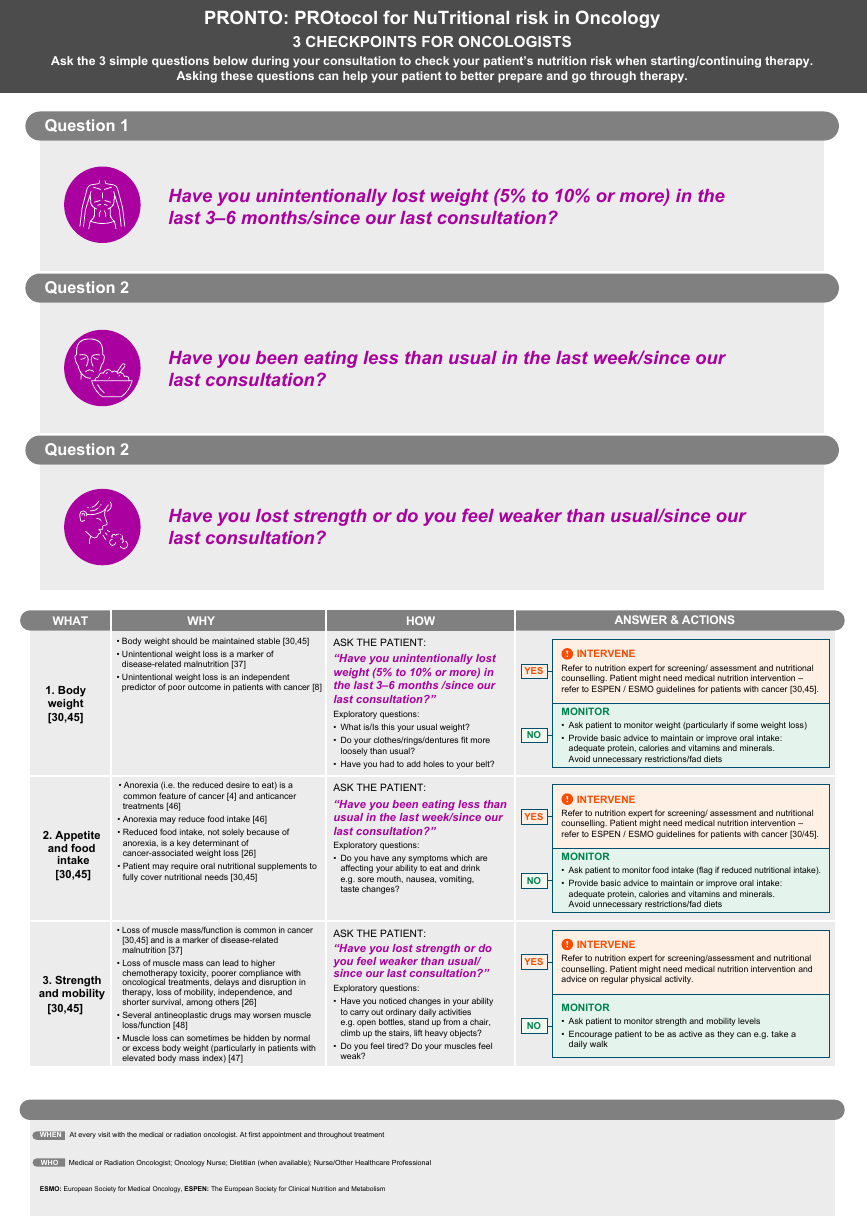
Figure 1. PRONTO: PROtocol for NuTritional risk in Oncology